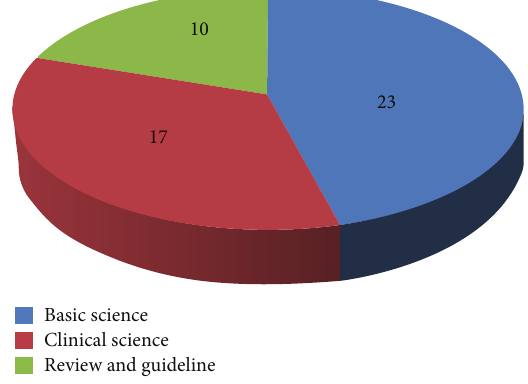
Figure 1: Distribution of categories.